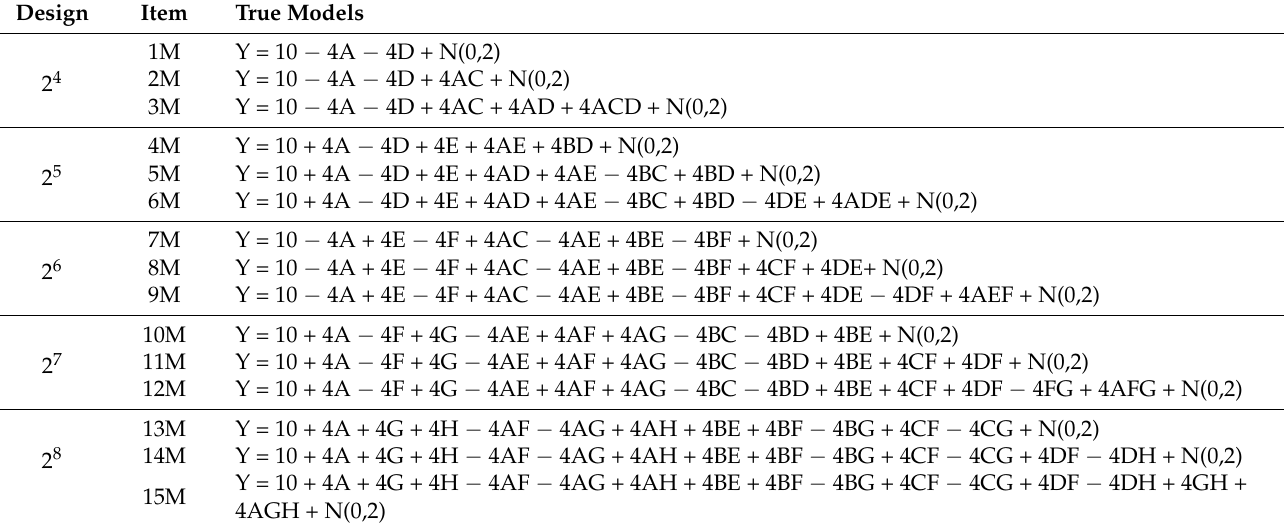
Table 4. True models with medium noise.